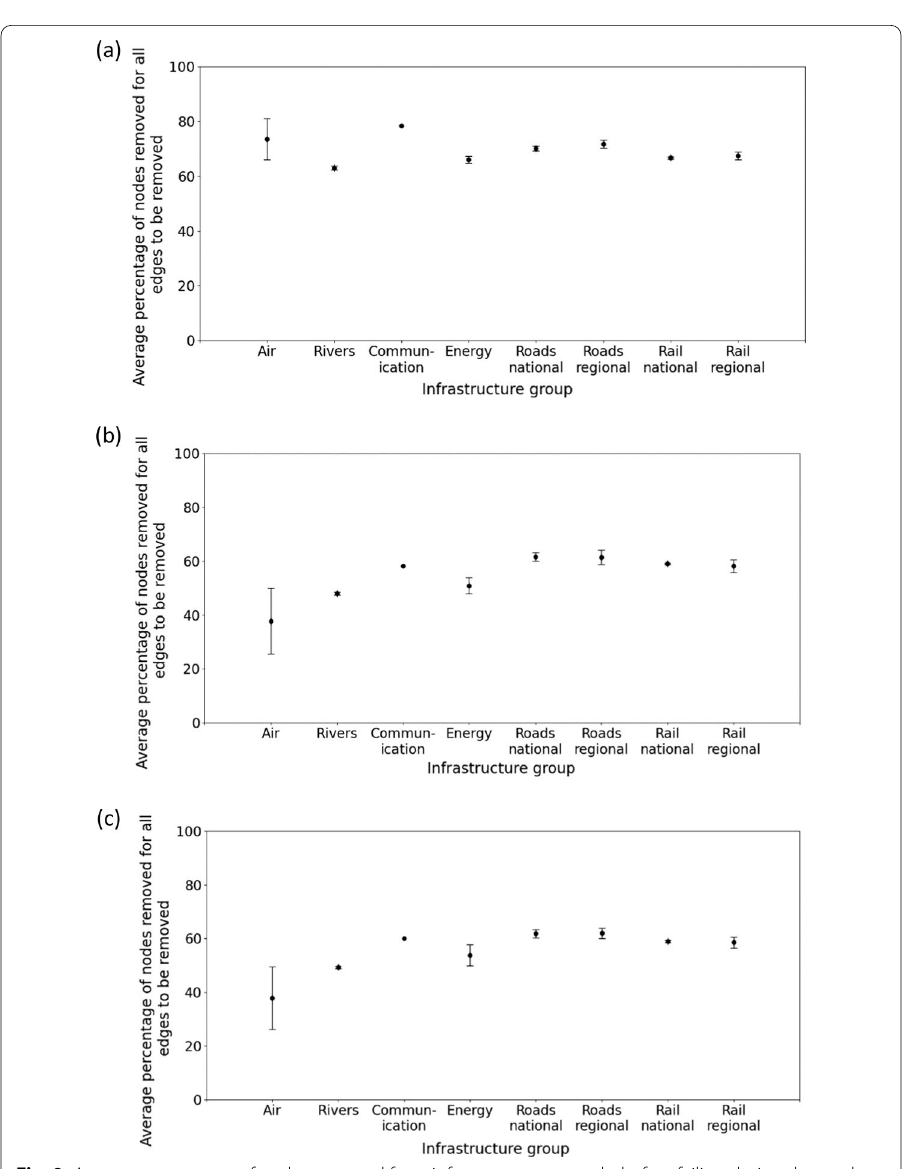
Fig. 9 Average percentage of nodes removed from infrastructure networks before failing during the random ( a ), degree ( b ) and betweenness ( c ) failure